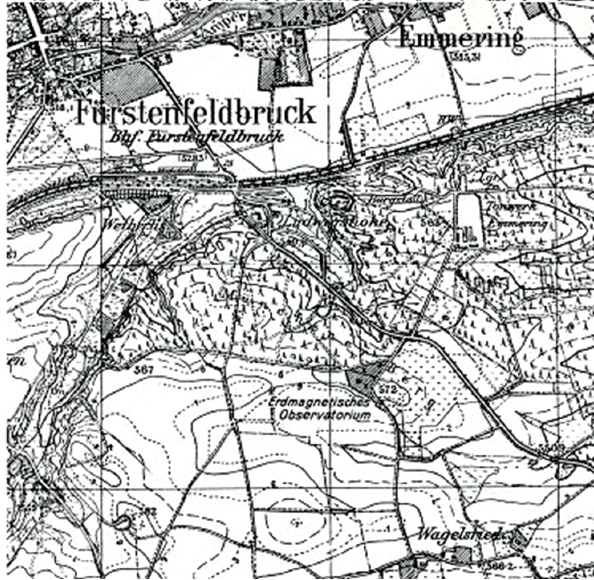
Figure 15. Map of the region south of Fürstenfeldbruck with the area of the observatory (Erdmagnetisches